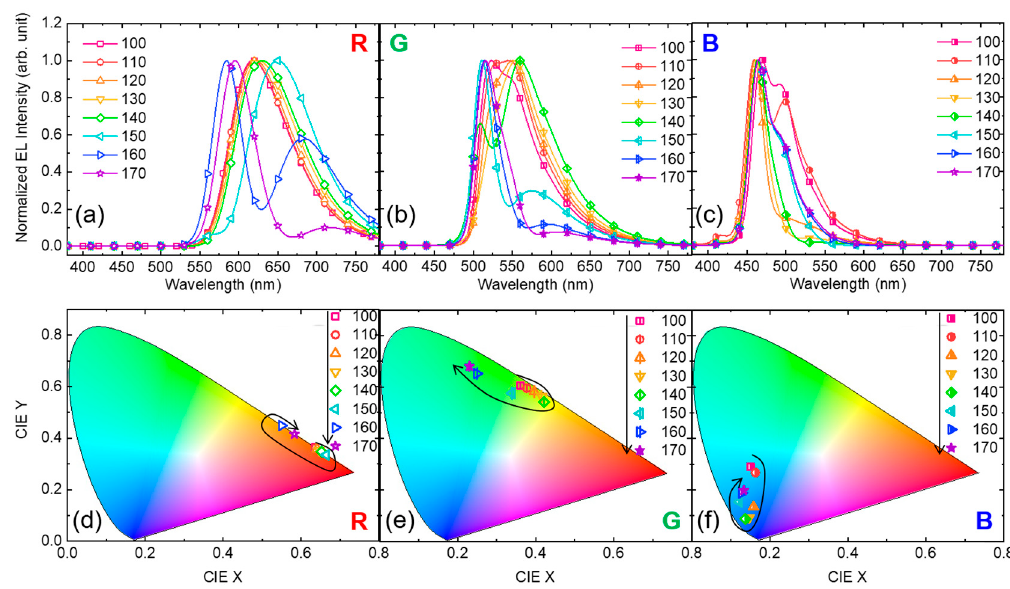
Figure 4. Electroluminescence (EL) spectra and CIE 1931 chromaticity diagram with colour coordinates of ( a , d ) R at 5.4 V, ( b , e ) G at 4.5 V, and ( c , f ) B at 4 V OLEDs with micro-cavity structure embedded cathodes depending on OSL thicknesses.